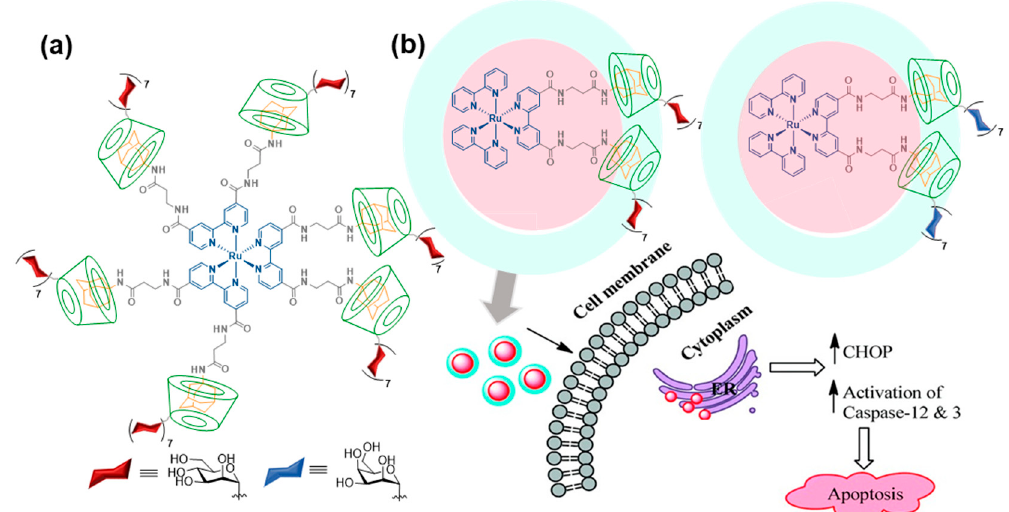
Figure 3. Heptamannosyl- β CD/Ru(II)-scaffolded hexa-adamantyl host–guest complex reported by Seeberger and coworkers [38] ( a ) and bis-adamantyl analogs with anti-apoptotic activity reported by Kikkeri and coworkers [40] ( b ). Adapted with permission from Reference [40]. Copyright 2016 Royal Society of Chemistry.